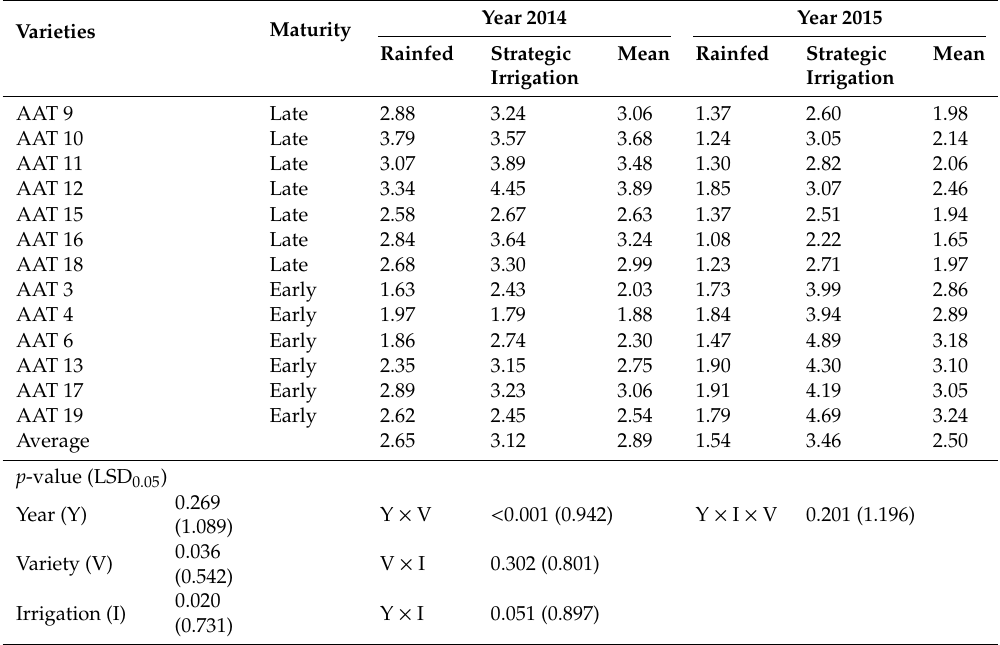
Table 2. Leaf area index (m 2 / m 2 ) at flowering of rice varieties under strategic irrigation and rainfed conditions at Alton Downs, in 2014 and 2015. AAT = Australian Agricultural